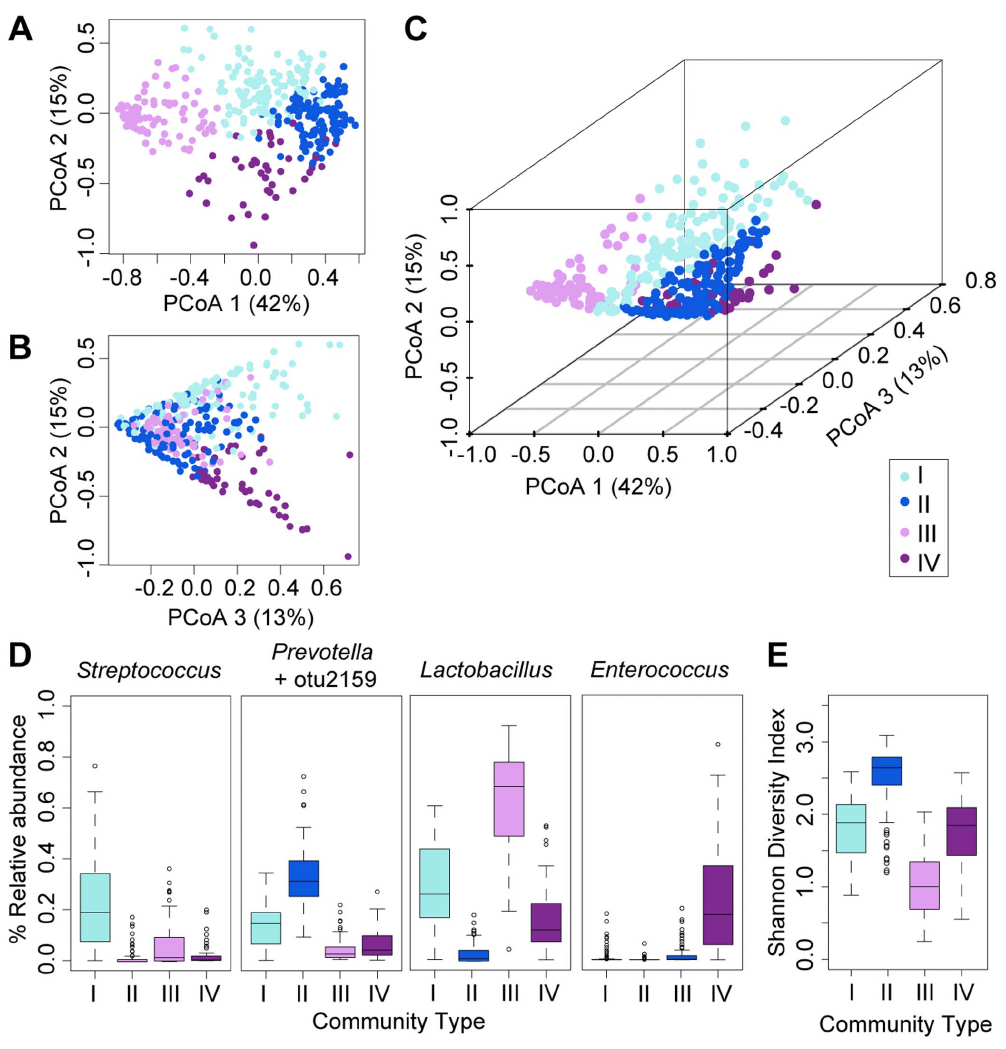
Figure 3. Community types within the fecal microbiota of cynomolgus macaques. ( A–C ) Principal coordinates analysis (PCoA) of axes 1 vs. 2 ( A ), 2 vs. 3 ( B ), and a three-dimensional plot of axes 1–3 ( C ) based on Jensen-Shannon divergence of all samples (n=374), color-coded by community type clusters identified by the partitioning around medoids (pam) clustering algorithm. Percent variance is shown for each axis. ( D ) Boxplots of the median relative abundance (y-axis) of dominant genera and ( E ) Shannon diversity index (y-axis), observed in each community type (x- axis). Error bars indicate the interquartile range between the first and third quartiles. doi:10.1371/journal.pone.0064212.g003 study 3 macaques were of Philippine origin (n= 3). Combining the genotype analysis, we observed that cynomolgus macaques from data regarding composition of the fecal microbiota with the STR different geographic origins harbored different communities of